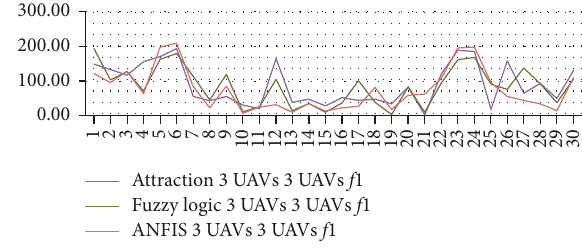
Figure 21: La Palma results comparison for 3 UAVs in free formation.